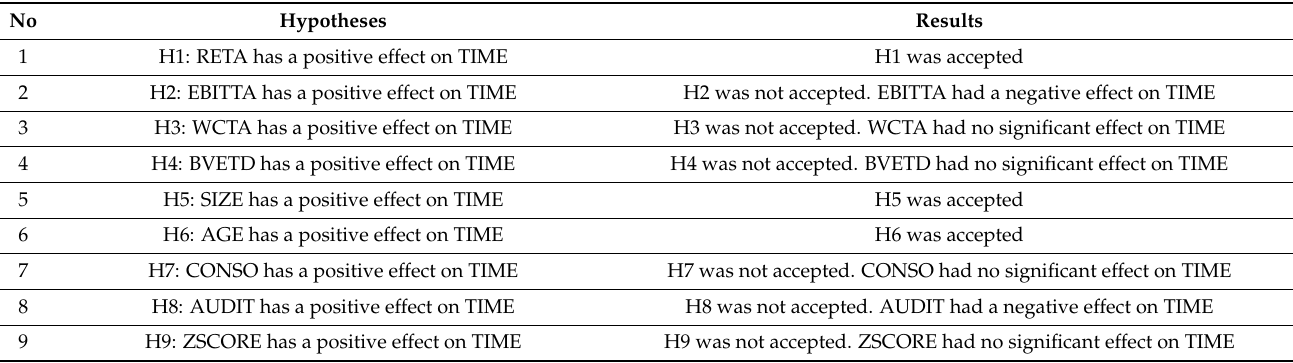
Table 10. Summary of hypotheses testing